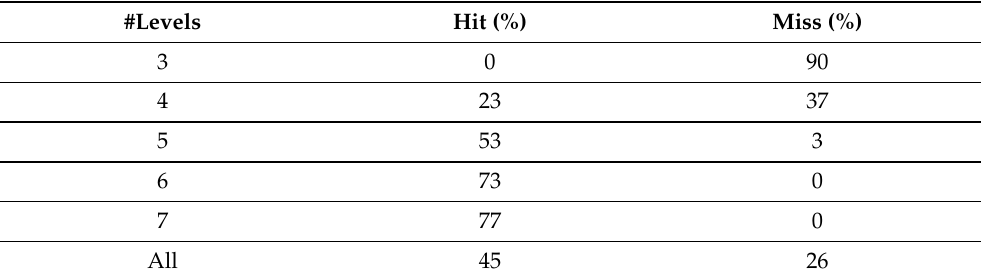
Table 7. Improvement of CARRY-MAP with respect to VIV-MAP in area optimization taking into account both area and